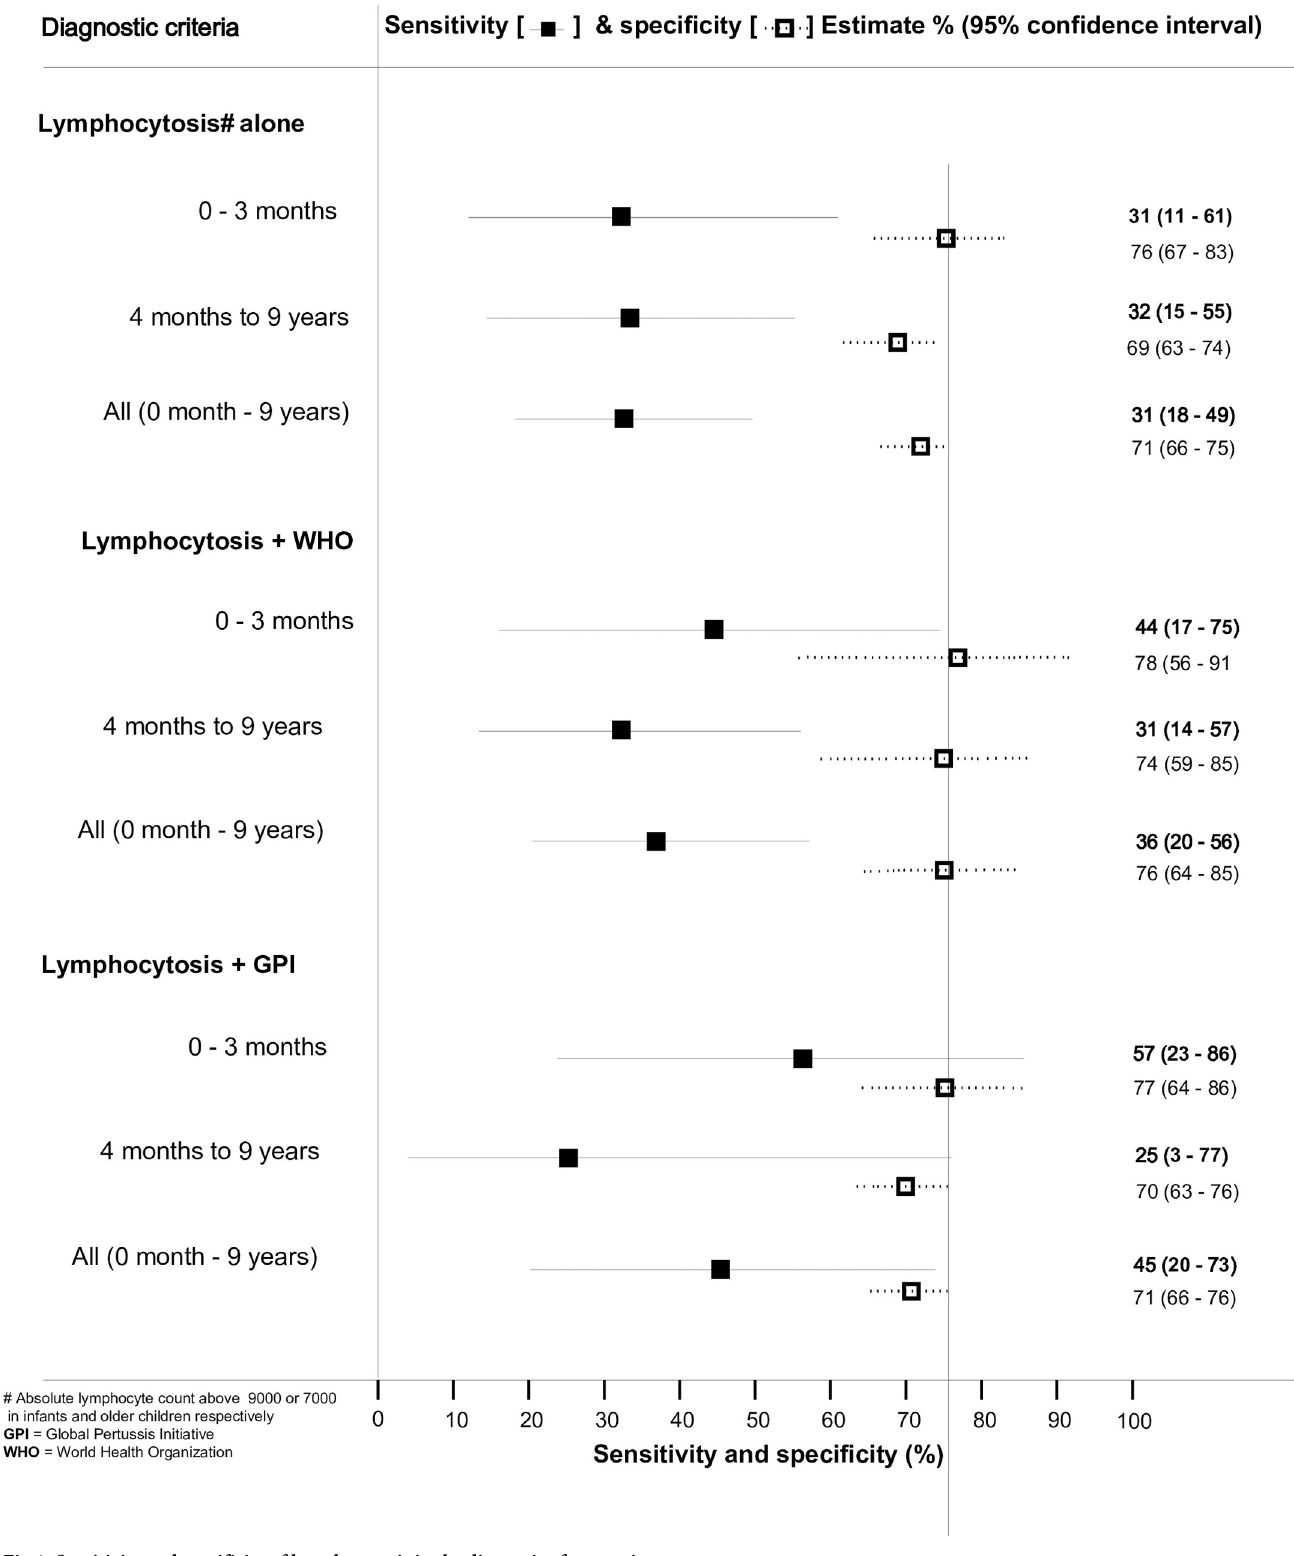
Fig 4. Sensitivity and specificity of lymphocytosis in the diagnosis of pertussis.